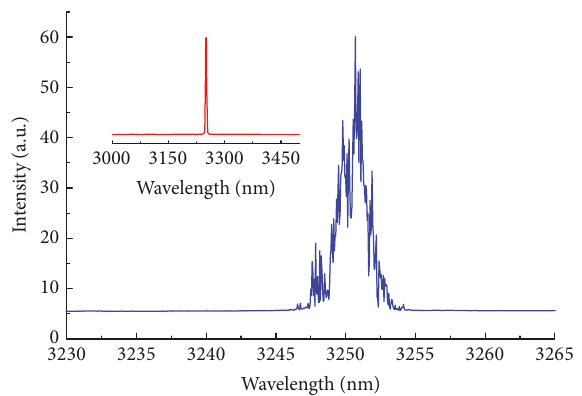
Figure 5: The idler spectrum of MgO:PPLN crystal at the tempera- ture of 120 ∘ C and the grating period of 30.5 𝜇